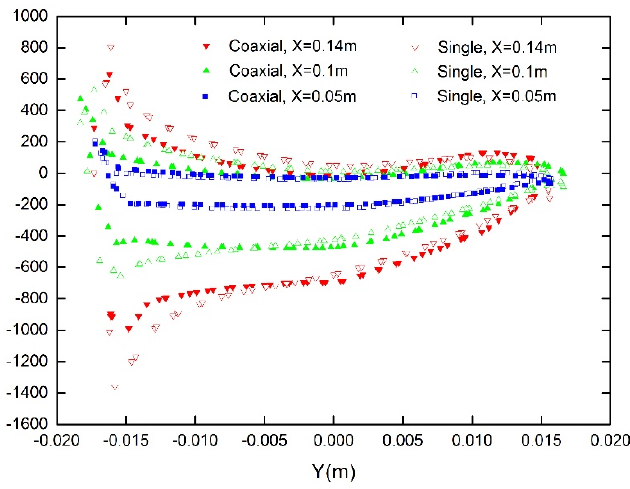
Figure 18. Surface pressure of ducted single and coaxial upper propellers.